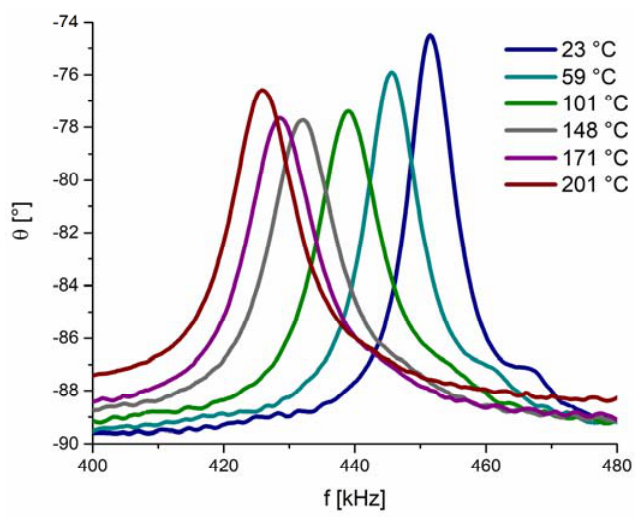
Figure 4. Phase angle θ as a function of frequency f for the free ‐ standing BFO piezoelectric disc measured at six different temperatures. The density of measured points is 4 kHz − 1 .